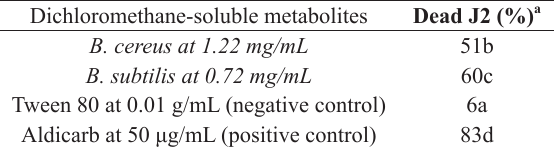
Figure 1 - Metabolites produced by Bacillus cereus and B. subtilis